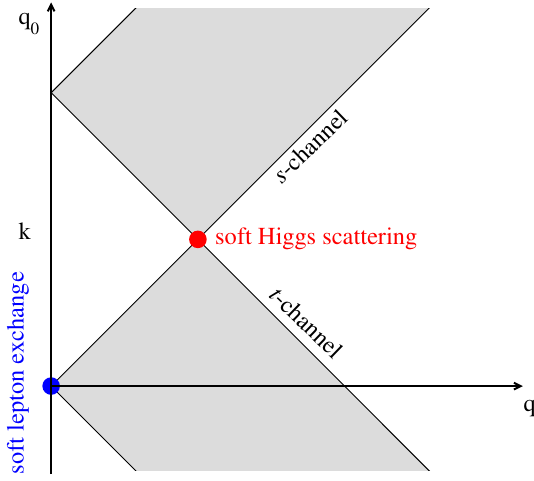
) parametrizes the 0 ) (cid:25) ( k; k ) whereas external 0